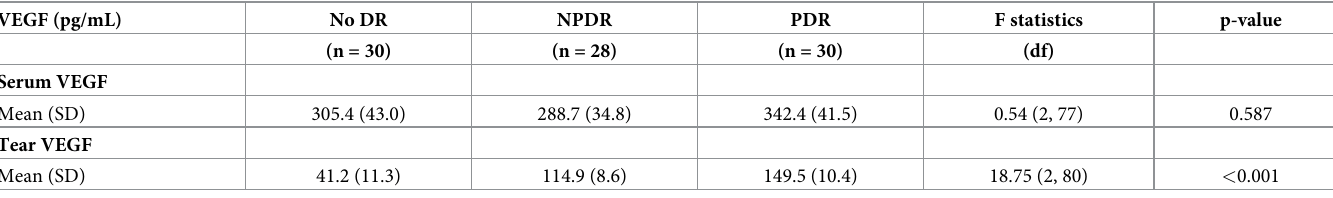
Table 2. Comparison of mean VEGF level in serum and tears between the groups. VEGF